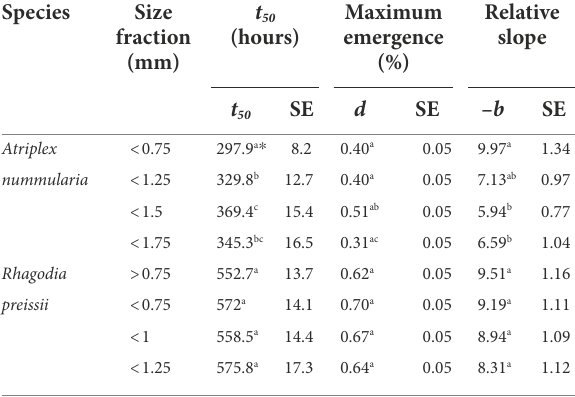
TABLE 8 The influence of seed size on the germination of A. nummularia and R. preissii expressed by the estimated parameters and their associated standard errors (SE) for each size